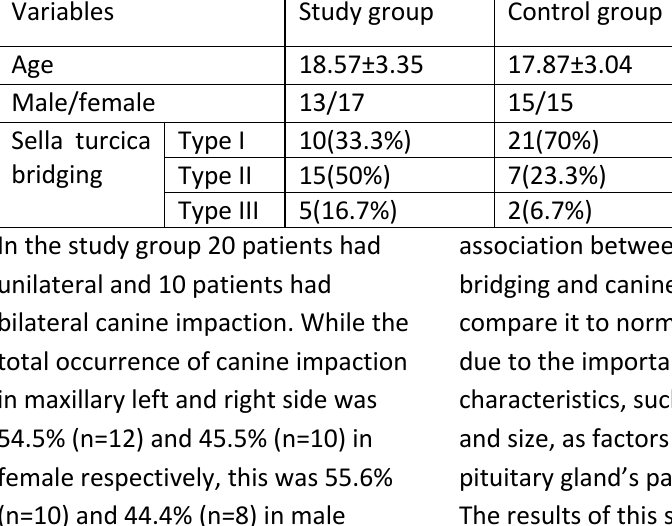
in maxillary left and right side was 54.5% (n=12) and 45.5% (n=10) in female respectively, this was 55.6% (n=10) and 44.4% (n=8) in male (Z=0.06, P-value=0.949).